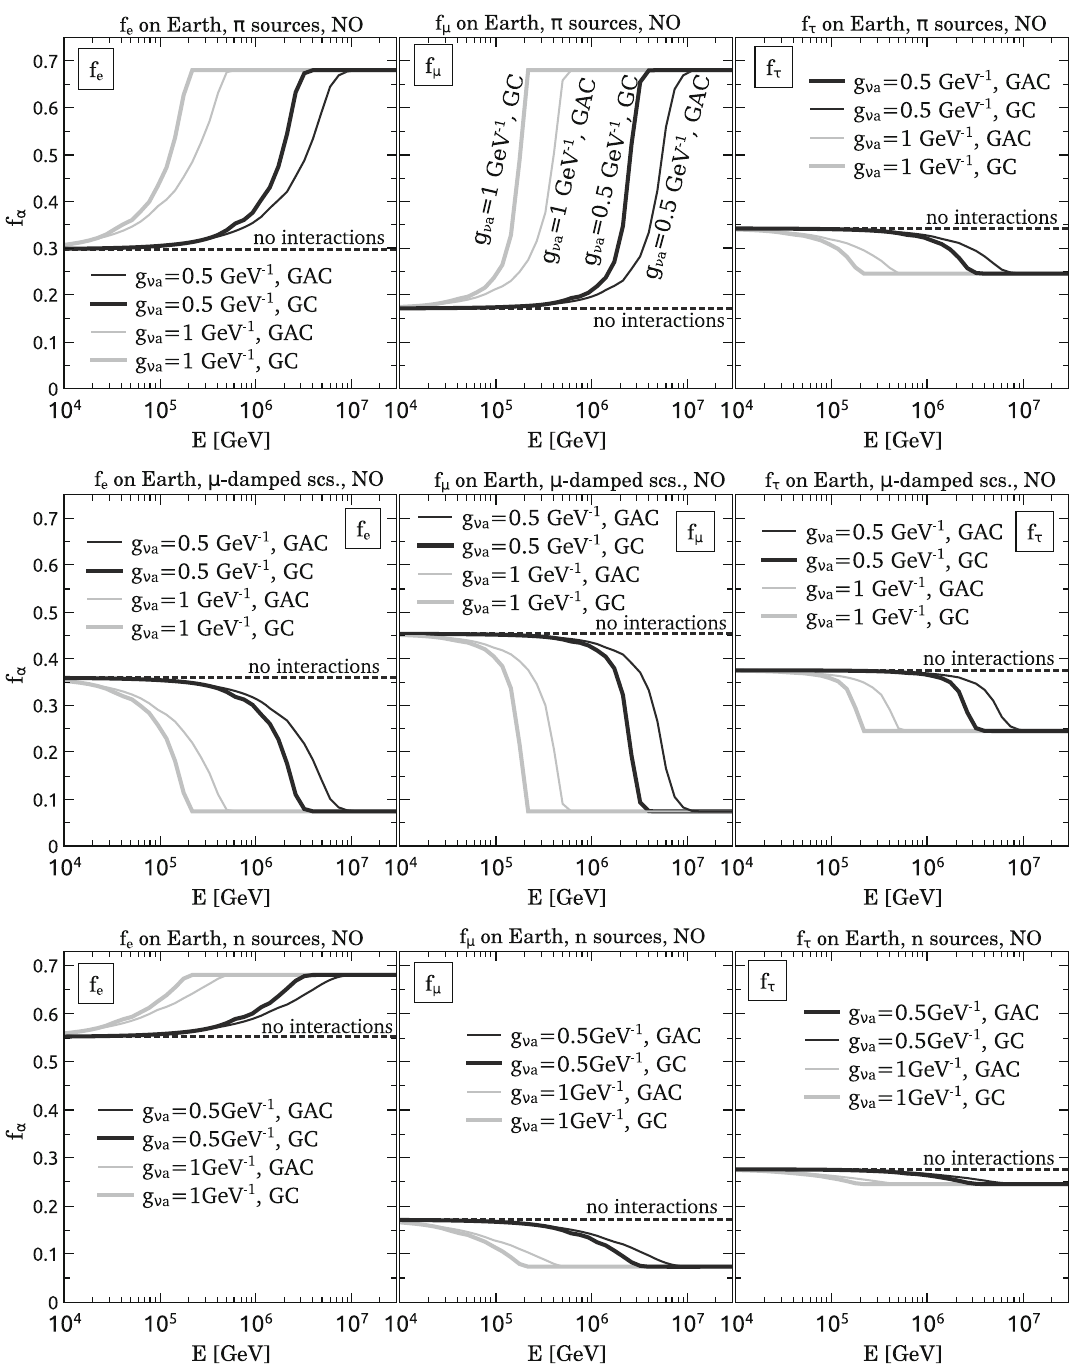
respond to the other half of the sky containing the galactic anti-center (GAC). The results for no interactions are marked using dashed lines. Top panels correspond to pion decay sources, middle panels to muon damped sources, and bottom panels to neutron decay